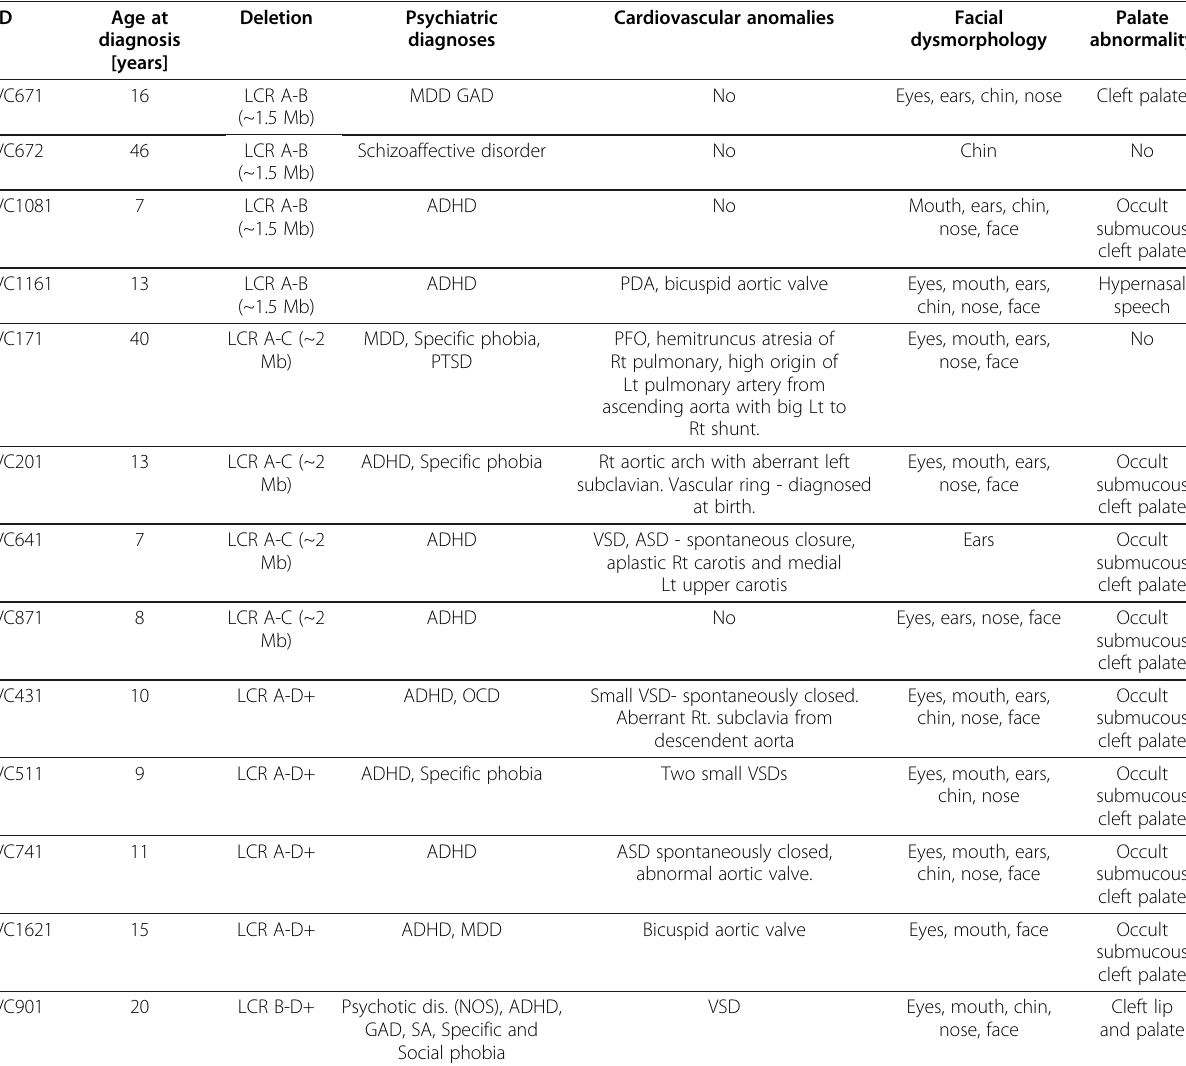
Table 3 Clinical data of 22q11.2DS subjects with non-TDR deletion